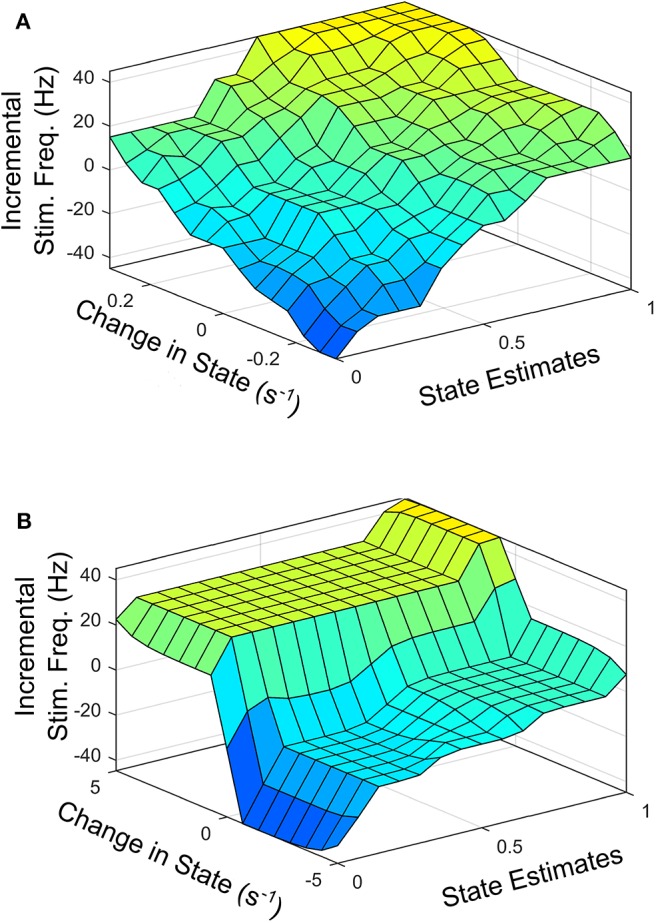
Surface plot for input-output relationship for: (A) SVM based controller, (B) GMM based controller.